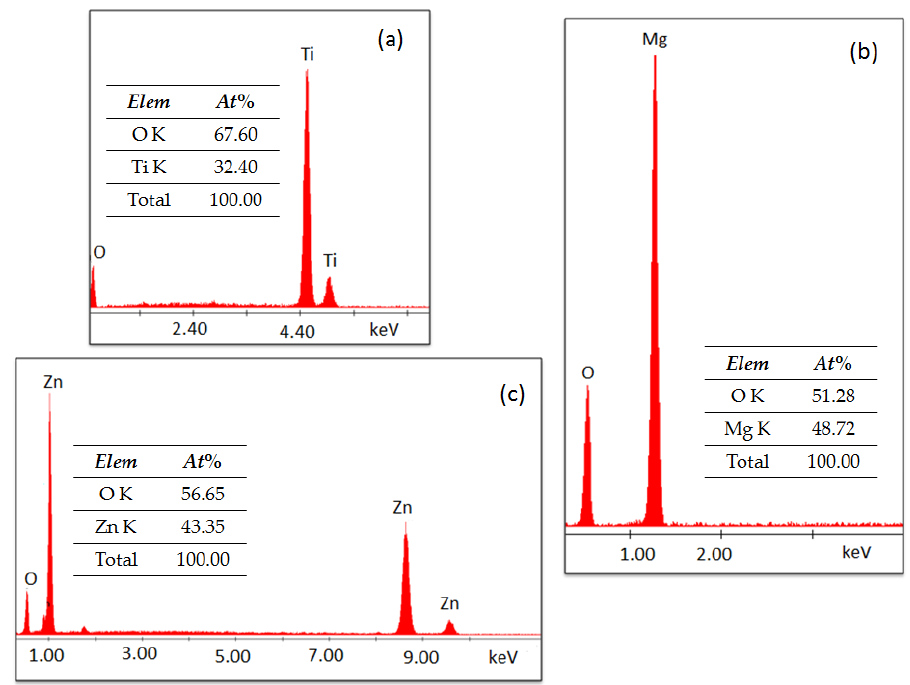
Figure 6. EDX spectra for TiO 2 ( a ), MgO ( b ) and ZnO ( c ).